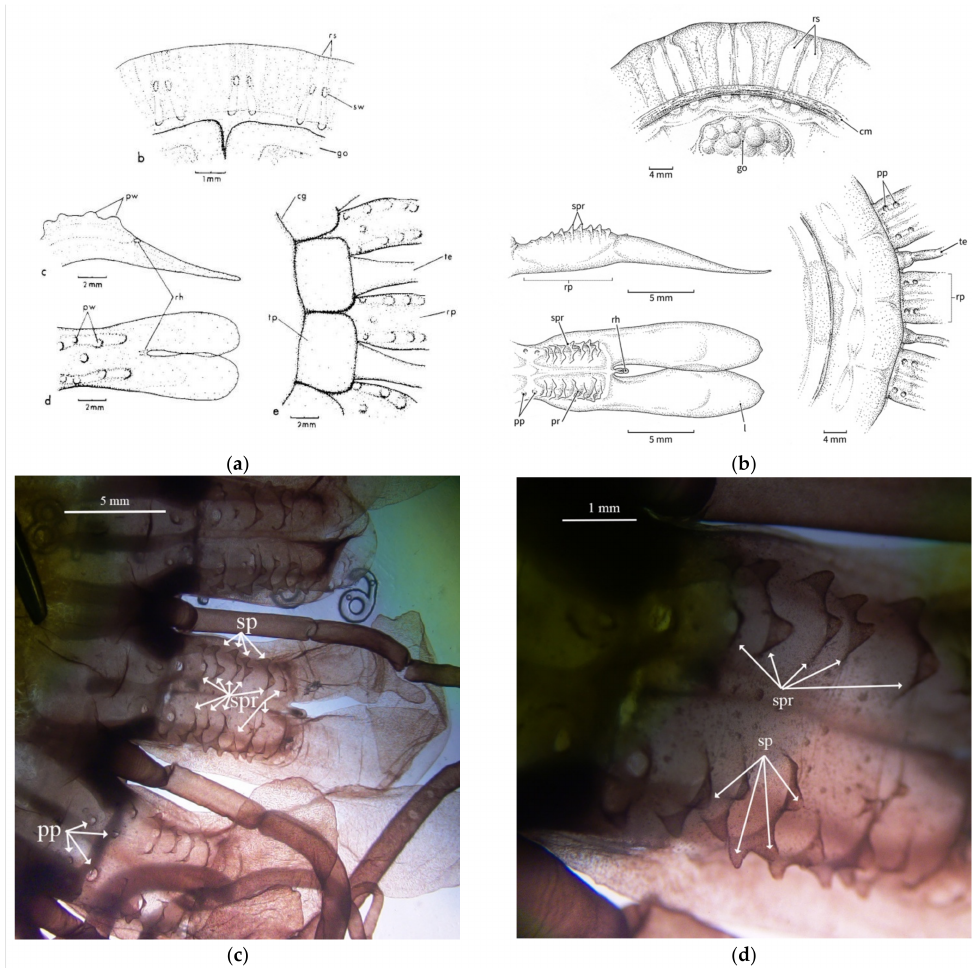
Figure 5. ( a ) Line drawing showing the pedaliar wart (pw) and septal wart (sw) pattern for Atolla chuni (from Larson [3] and used with permission under license number 5203151138336) and ( b ) the spikes on the rhopaliar pedalia for Atolla reynoldsi sp. nov. (drawn from photographs). Dissection microscope images ( c ) 7.5 × and ( d ) 30 × of the papillae (pp), spikes (sp), and the spike ridges (spr) of Atolla reynoldsi sp. nov (D1369D1). There were no septal warts observed. l lappet; rp rhopaliar pedalia; rh rhopalium; cm coronal muscle; te tentacle; go gonad; rs radial septa; pw pedaliar wart; sw septal wart; pp papillae; sp spike; spr spiked